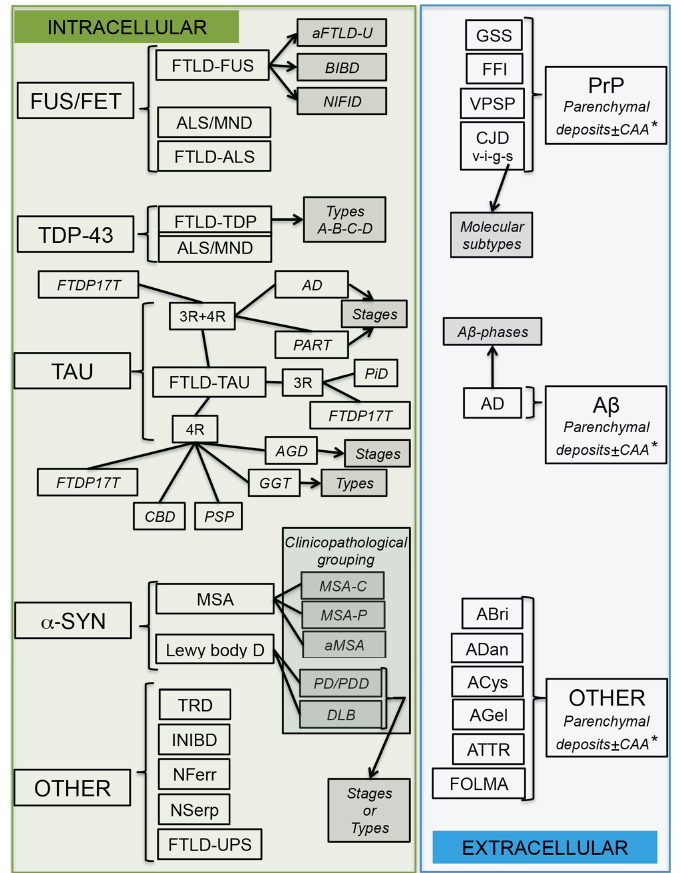
Figure 4. Algorithm for the classification of neurodegenerative proteinopathies, Abbreviations: Abri and ADan: amyloidoses related to familial British dementia and familial Danish dementia; ACys: amyloidosis related to Cystatin C amyloid; AD: Alzheimer disease; AGD: Argyrophilic grain disease; AGel: amyloidosis related to Gelsolin amyloid; ATTR: amyloidosis associated with transthyretin amyloid; ALS: amyotrophic lateral sclerosis; BIBD: Basophilic inclusion body disease; CAA: sporadic cerebral amyloid angiopathy; CBD: Corticobasal degeneration; CJD: Creutzfeldt-Jakob disease; DLB: Dementia with Lewy bodies; FFI: fatal familial insomnia; FOLMA: familial oculoleptomeningeal amyloidosis; FTLD: frontotemporal lobar degeneration; aFTLD-U: atypical FTLD with ubiquitinated inclusions; FTLD-UPS: FTLD with inclusions immunoreactive only for the components of the ubiquitine proteasome system; FTDP-17T: Frontotemporal dementia and parkinsonism linked to chromosome 17 caused by mutations in the MAPT (tau) gene; GGT: globular glial tauopathies; GSS: Gerstmann-Sträussler-Scheinker disease; INIBD: intranuclear inclusion body diseases; MND: Motor neuron disease; MSA: multiple system atrophy (C: cerebellar, P: Parkinsonism, aMSA: atypical MSA); NFerr: neuroferritinopathy; NIFID: Neurofilament intermediate filament inclusion disease; NSerp: neuroserpinopathy; PART: primary age-related tauopathy; PD: Parkinson disease; PDD: PD with dementia; PiD: Pick disease; PSP: Progressive supranuclear palsy; TRD: trinucleotide repeat expansion disorder: refers to genetic disorder and associated with different proteins; VPSP: variably proteinase sensitive prionopathy. For CJD, v: indicates variant, s: sporadic, i: iatrogenic, and g: genetic CJD. Kuru is not indicated in this figure. Note that overlap between FTLD-TDP and ALS/MND indicates combined phenotypes (FTLD-ALS/MND). * indicates that PrP-CAA is very rare; for A β , CAA is frequent, for other amyloidoses, CAA is more frequent than parenchymal deposits. Note that FTLD-ni is not indicated here, since no proteinopathy is associated with it. + indicates with or without. Green and blue coloured box indicates intra-, or extracellular proteins; gray box indicates clinical and/or pathological subtypes; arrows point to subtyping based on pathological aspects.